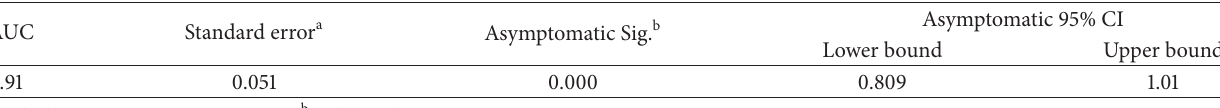
Table 2: Statistics of the area under the curve of the ROC curve for the ABPI against diagnosis of PAD by arterial colour duplex scan. AUC Standard error a Asymptomatic Sig. b